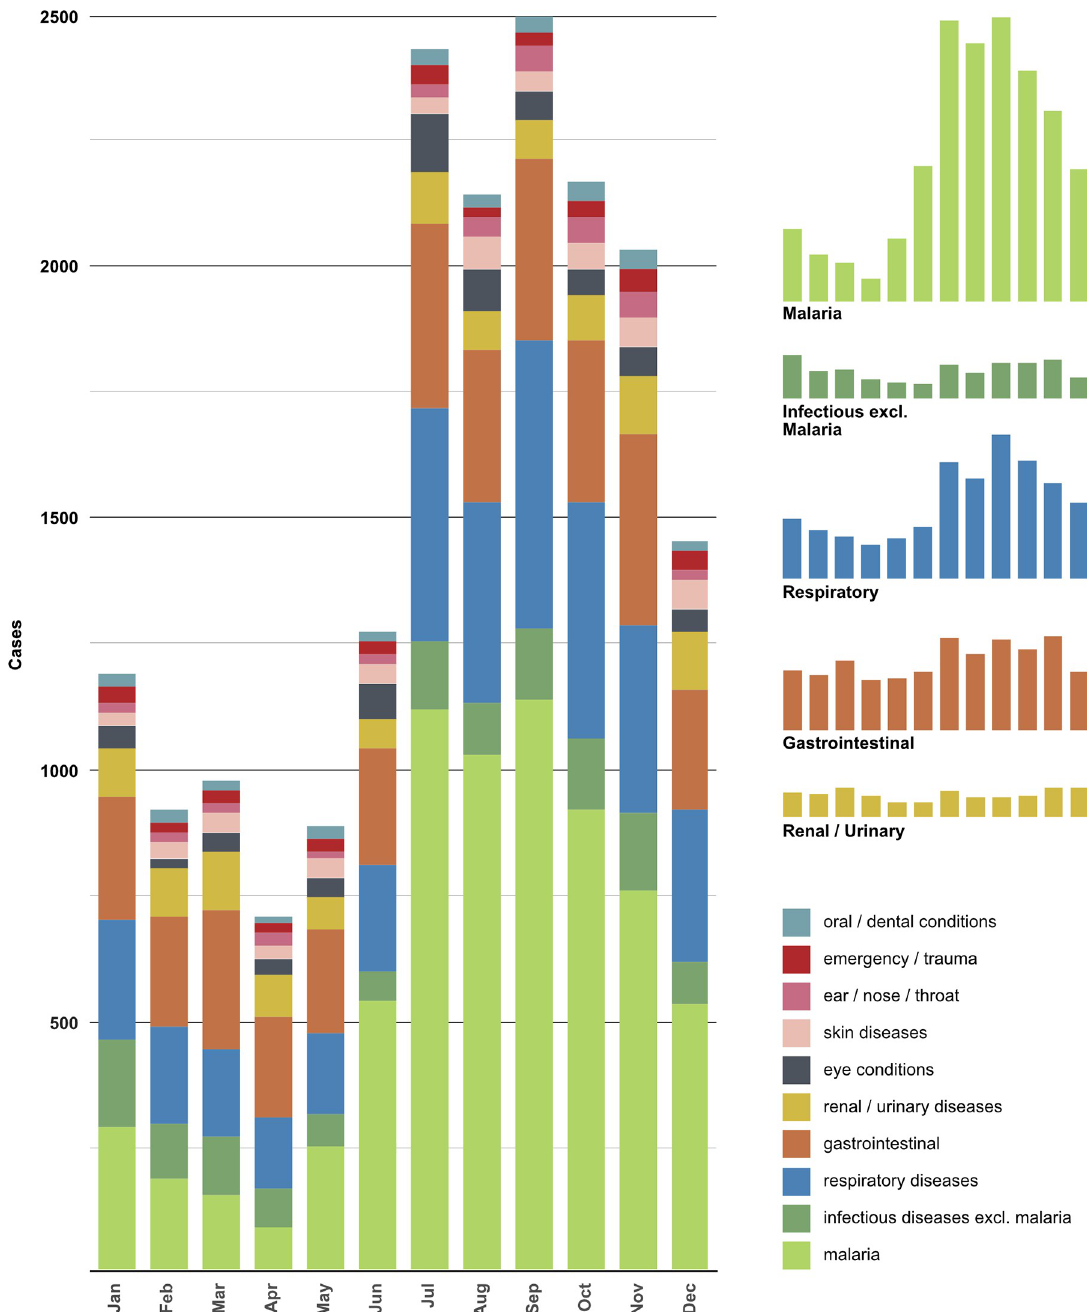
Fig 1. Diagnosis categories treated at AYPC in 2019. This graph was created using Affinity Designer Software [31]. Each bar in the graph indicates a different month of the year. Within each bar, the height of the sections indicates the number of cases for a particular diagnosis category. The trends can be followed throughout the year based on the different colours. The smaller bar graphs to the side pull out information for top diagnosis categories to highlight trends throughout the year.